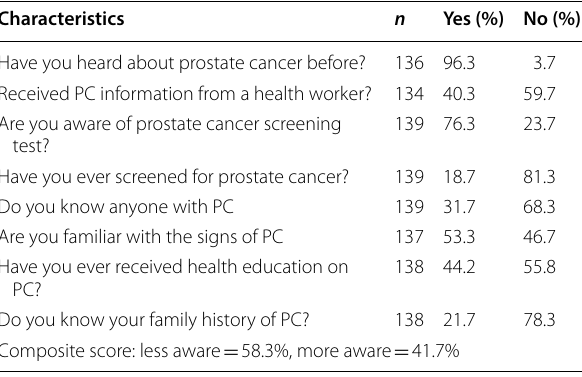
Table 1 Prostate cancer awareness among soldiers